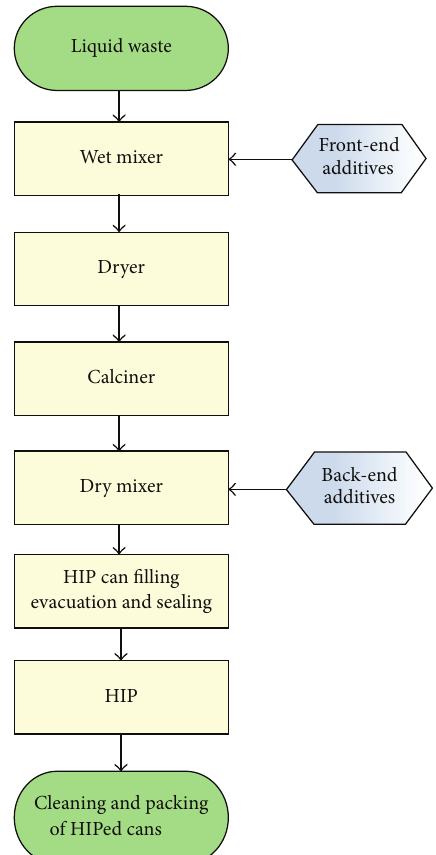
Figure 5: Schematic of the waste treatment